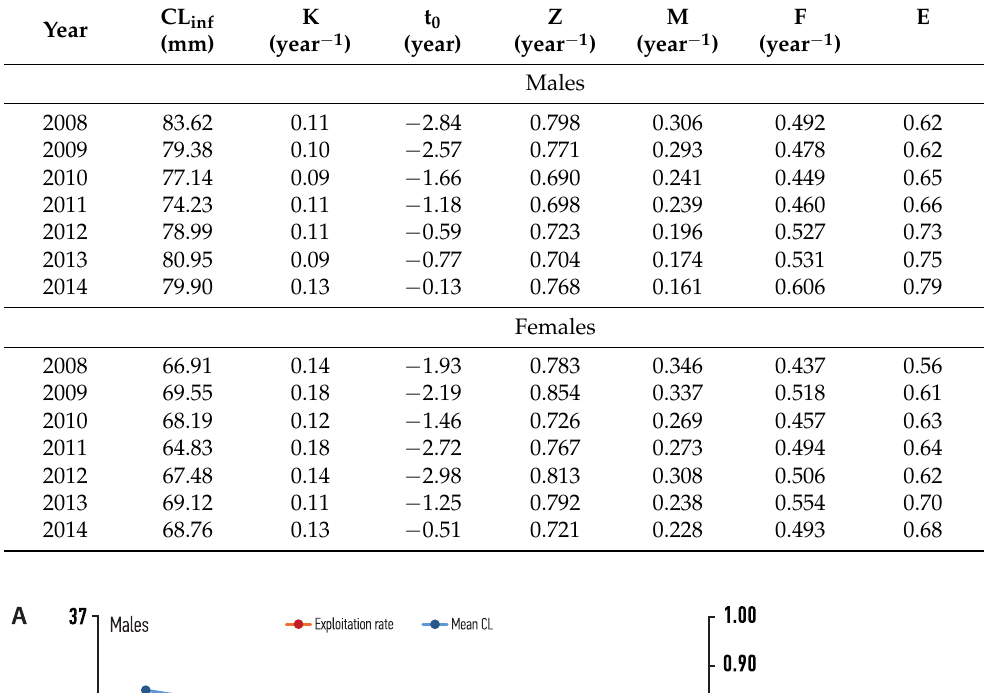
Table 2. Values of the Von Bertalanffy Growth Function of Nephrops, estimated by a non-linear regression and Morality values, estimated by several models incorporated in the FiSAT II software, for each year of sampling and for each sex. (CL inf = asymptotic carapace length, K = growth coefficient, t 0 = hypothetical age at zero length, Z = total mortality, M = natural mortality, F = fishing mortality, E = exploitation rate).